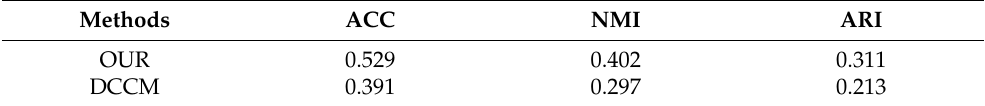
Table 4. The influence of different strategies on constructing r i , j